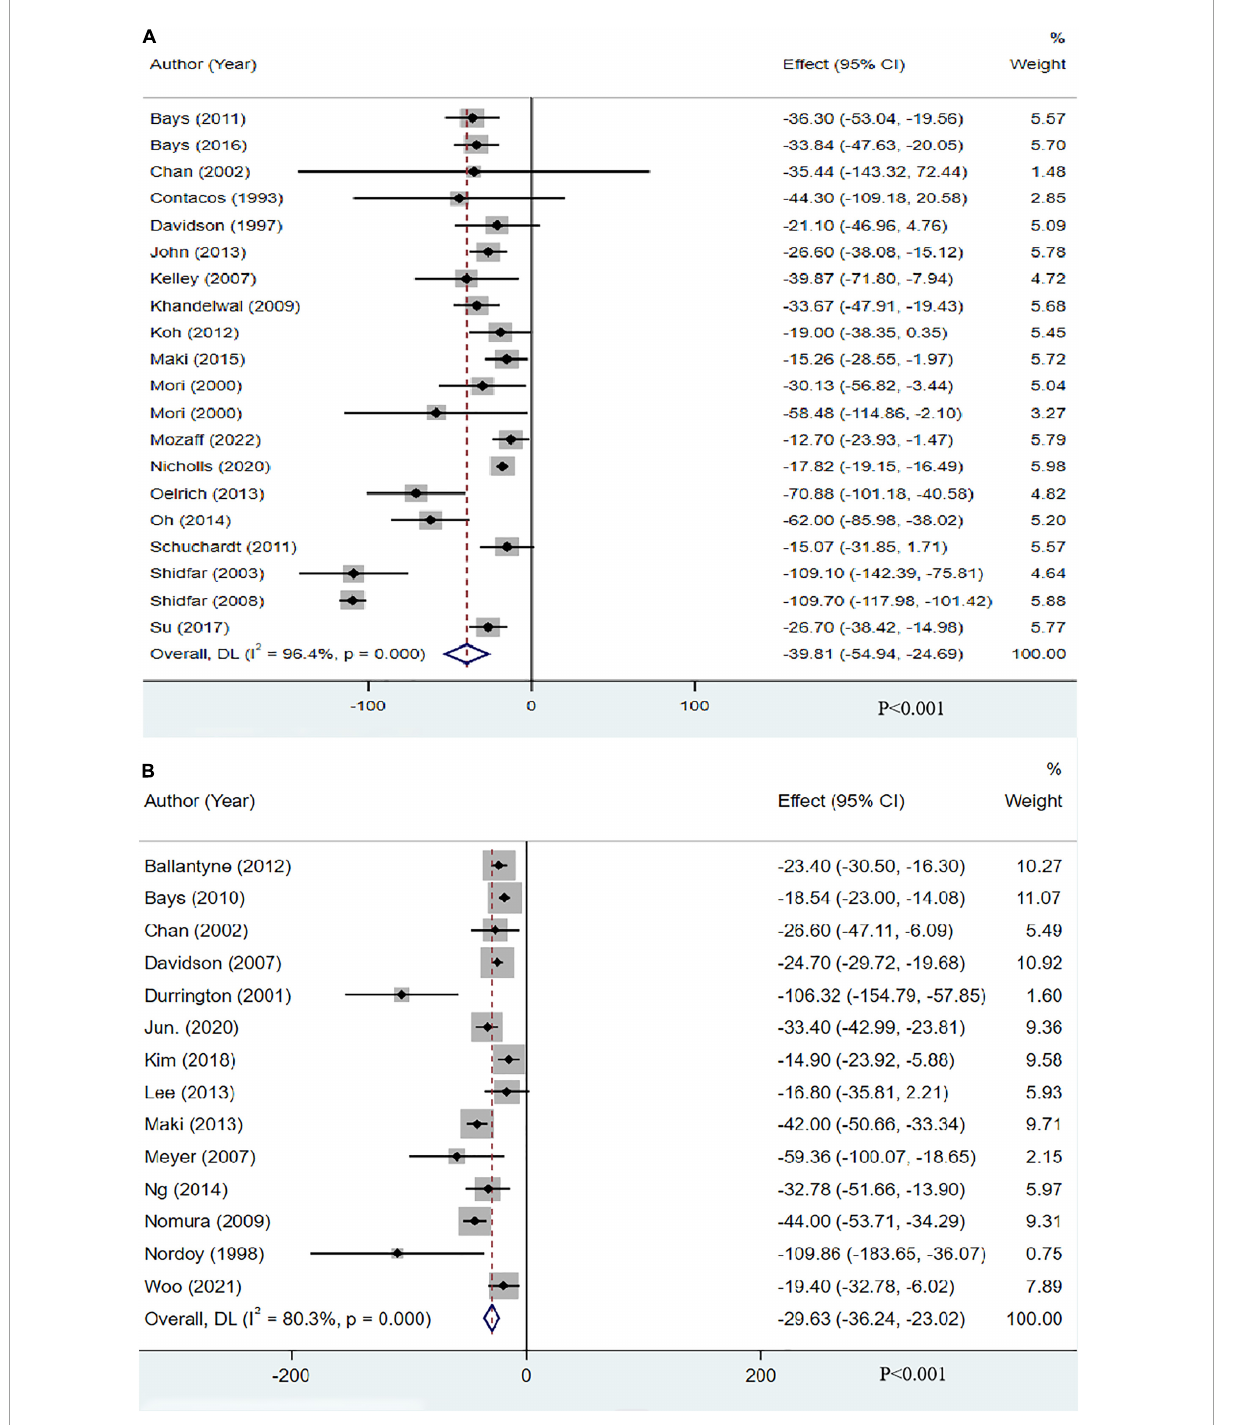
FIGURE3 The effect of OM3-FA on TG. (A) OM3-FA monotherapy; (B) Combined therapy of statins plus OM3-FA.